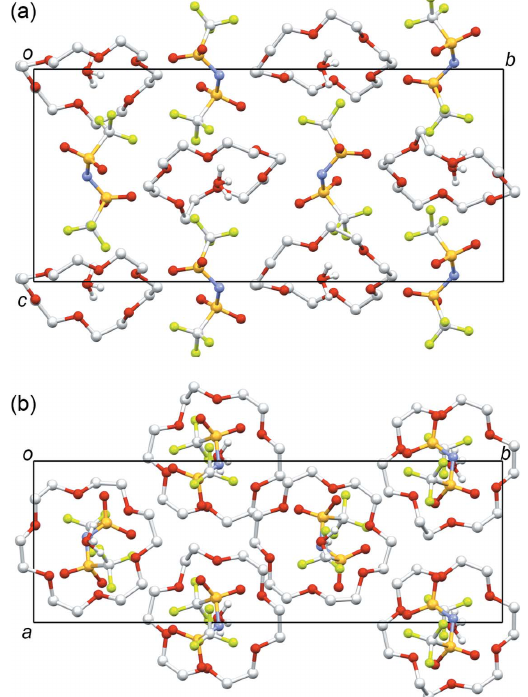
Figure 2 Structure of the title compound viewed along ( a ) the a axis and ( b ) the c axis. Hydrogen atoms of 18-crown-6 are omitted for clarity.